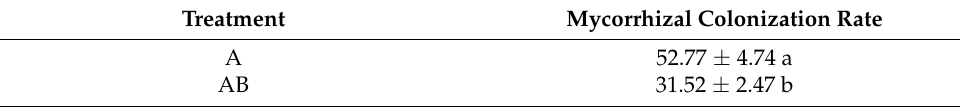
Table 1. Mycorrhizal colonization rates of maize following different